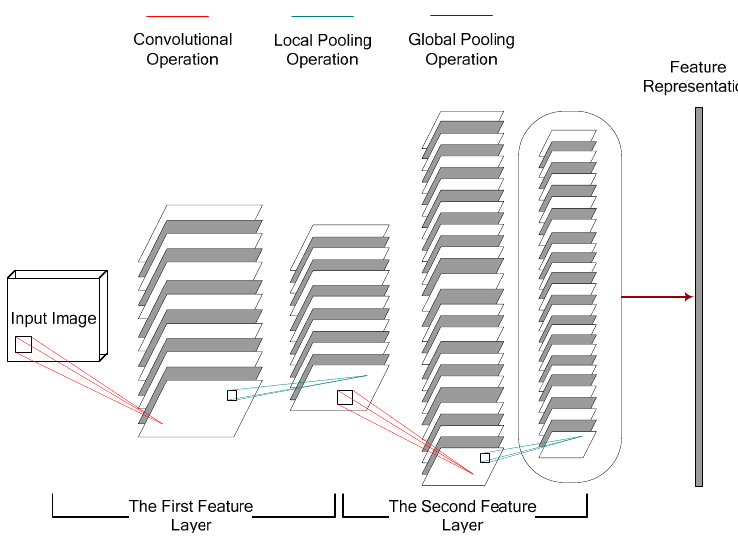
Figure 2. Unsupervised convolutional feature extraction network with two feature layers.